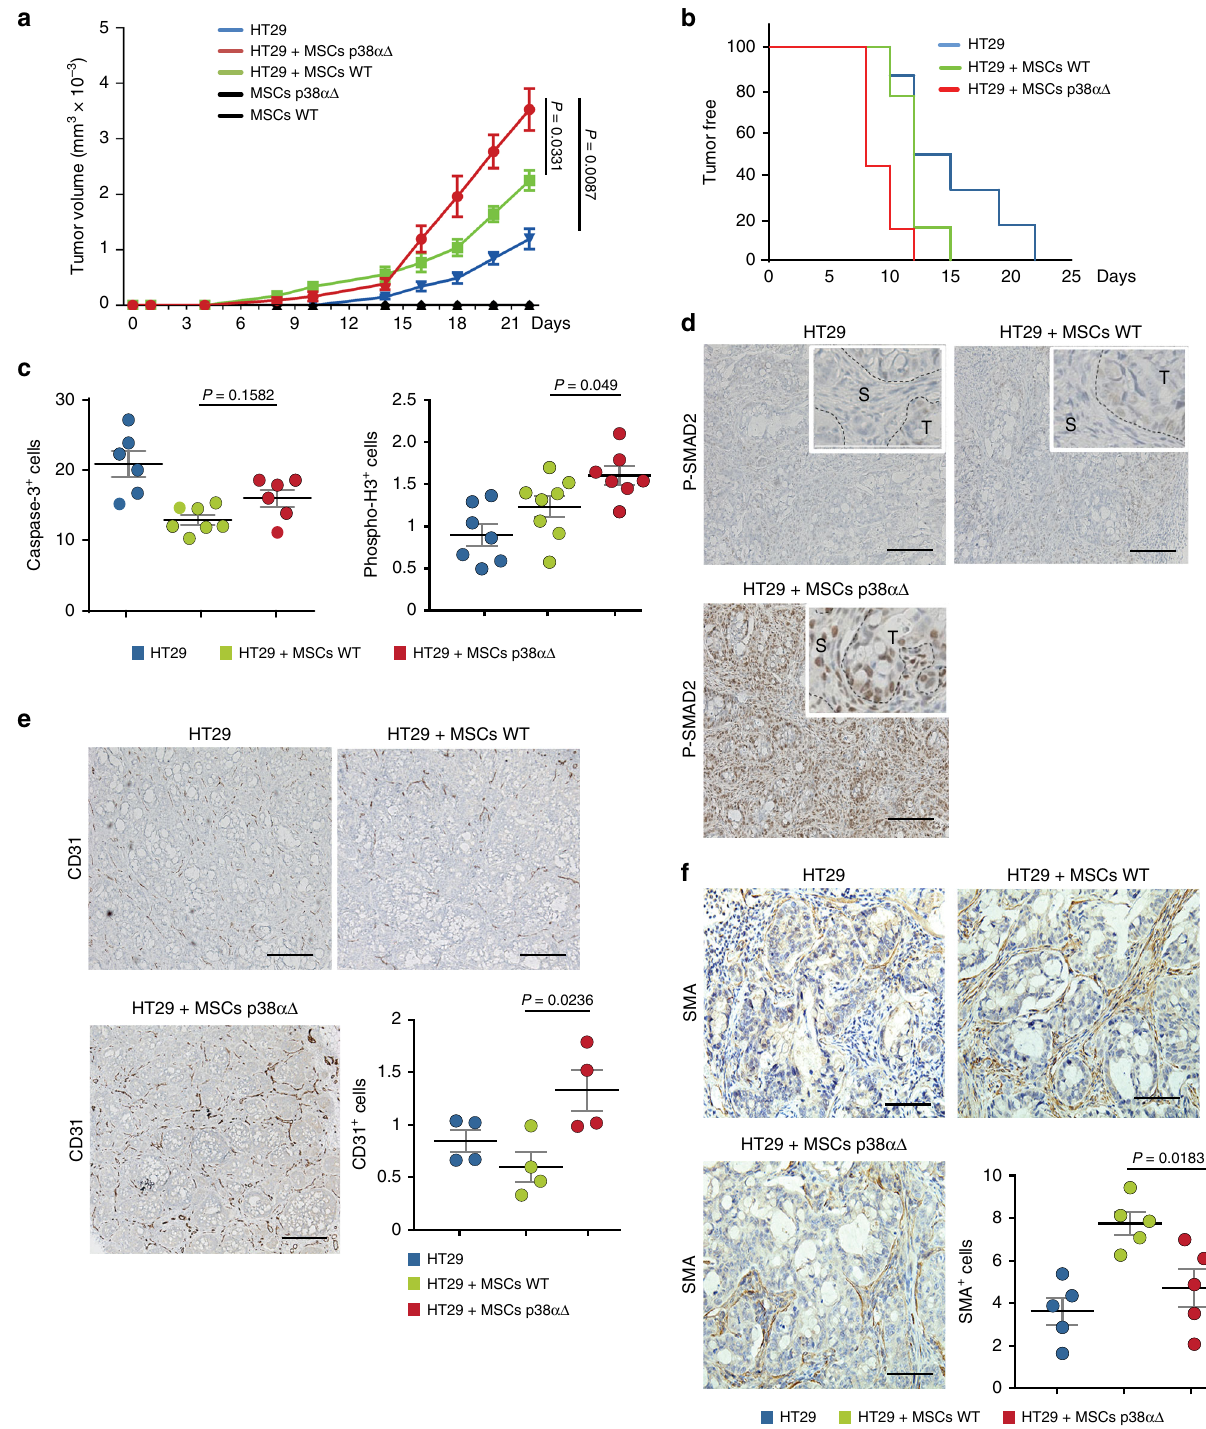
Fig. 7 p38 α -de fi cient MSCs enhance tumor formation and angiogenesis by colorectal cancer cells. a Growth kinetics of 2 × 10 6 HT29 colon cancer cells subcutaneously implanted into nude mice either alone or together with 5 × 10 5 WT or p38 αΔ MSCs. As a control, MSCs were also implanted alone. Values are mean ± SEM ( n = 8 tumors). b , Kaplan-Meier curves for the mice in ( a ). c Quanti fi cation of the number of Caspase-3 + cells per fi eld and of the area covered by phospho-Histone 3 + cells (percentage per fi eld) as markers of apoptosis and proliferation, respectively, in tumors obtained as in ( a ). Data are mean ± SEM ( n = 6 or 7 tumors). d Phospho-Smad2 antibody staining of tumors obtained as in a . T, tumor; S, stroma. Bars, 100 μ m. e CD31 antibody staining of tumors obtained as in ( a ). Bars, 100 μ m. The percentage of CD31 + cells among the total number of cells per fi eld was quanti fi ed using ImageJ. Data are mean ± SEM ( n = 4 tumors). f SMA antibody staining of tumors obtained as in ( a ). Bars, 100 μ m. The number of SMA + cells per fi eld was quanti fi ed using ImageJ. Data are mean ± SEM ( n =